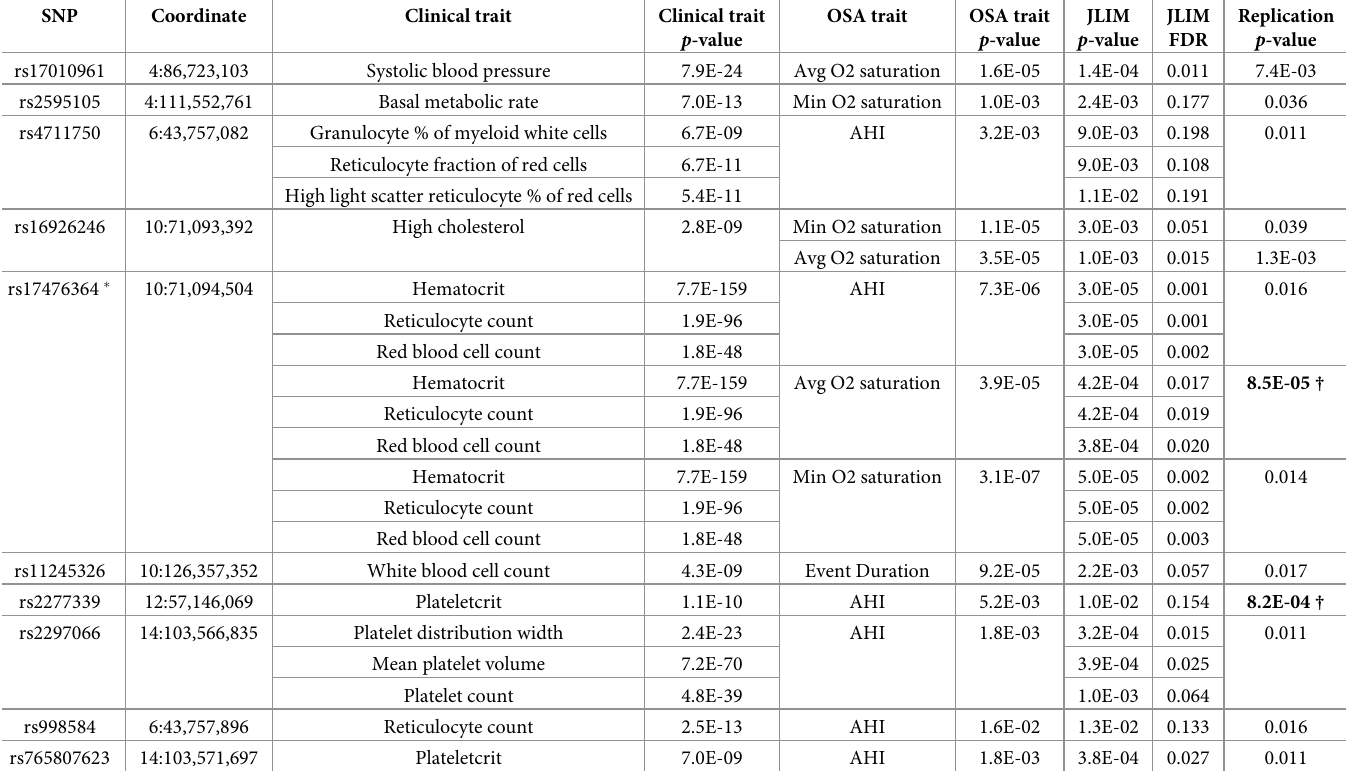
Table 1. Loci with significant pleiotropic associations between a clinical trait and an OSA trait with nominally significant replication. SNP Coordinate